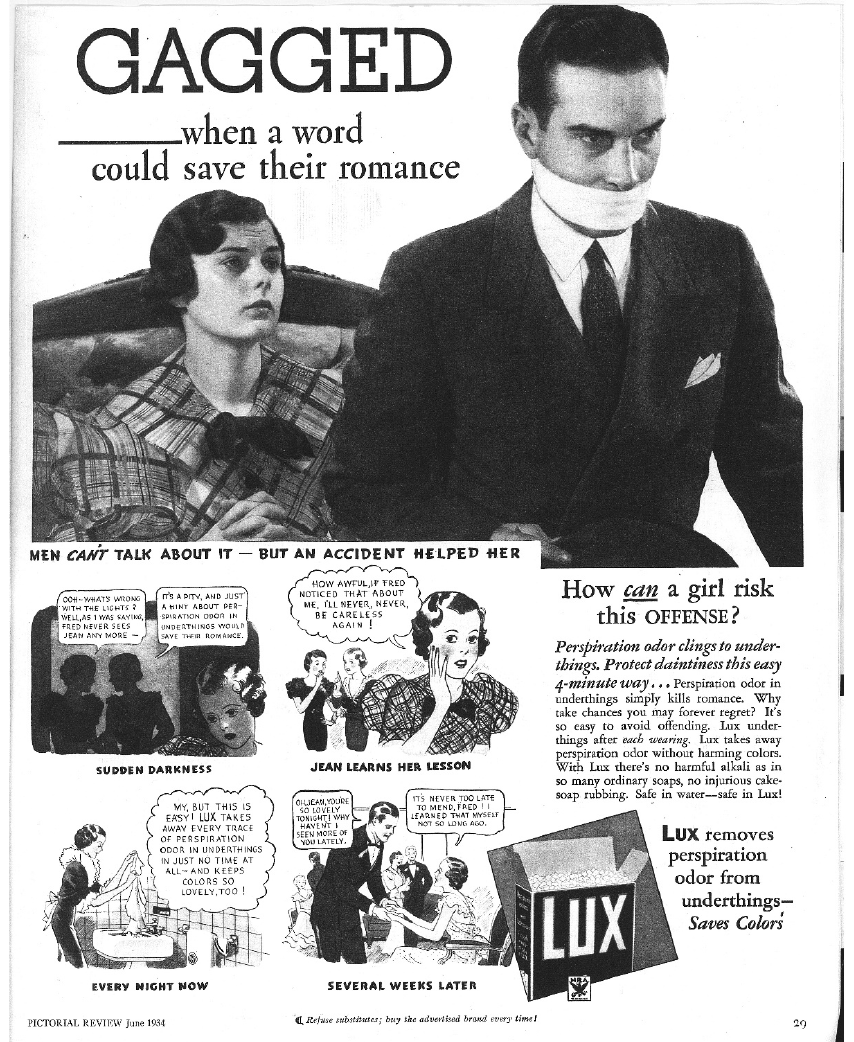
Figure 3. This ( Pictorial Review 1934, p. 29) Lux soap ad is one of many variations of comic-formatted narratives typical of products (Listerine is another) sold to cure bodily odors that ran in magazines for decades. Fascinating too, are the ad’s attendant instructions about what can and cannot be said aloud and to whom: “Men can’t talk about it”, the sub-heading to Jean’s story reads, but women apparently can talk about it with one another, just not to the woman with the problem. Importantly, this version of the advertising motif differs in permitting anyone else to name or to correct the lonely woman’s problem. More often, the voice of the product says through the various captions what the woman needs to know and, in diagnosing for the public’s education her easily preventable despair, consequently scares other women away from committing similar crimes of reprehensible fatuous- ness: “You never have it?” another ad asks rhetorically (“it” meaning “body odor”), then answers”,- - what colossal conceit !” (qtd. in Reichert 2003, p. 123). Such ads sometimes conveyed kinder messages of democratic physicality, a “…secularized version of the traditional Christian assurances of ulti- mate human equality” (Marchand 1985, p. 222). Disembodied, God-like voices, such as those of the floating, unattributed captions, speak about the bodies of others and demand humility from listen- ers in ways that “might be considered a secular translation of the idea that God ‘sends rain on the just and on the unjust’” (Marchand 1985, p. 222). Niedecker’s poems featuring women or presuma- bly female speakers 8 illustrate the heightened awareness and internal clamor the advertising-